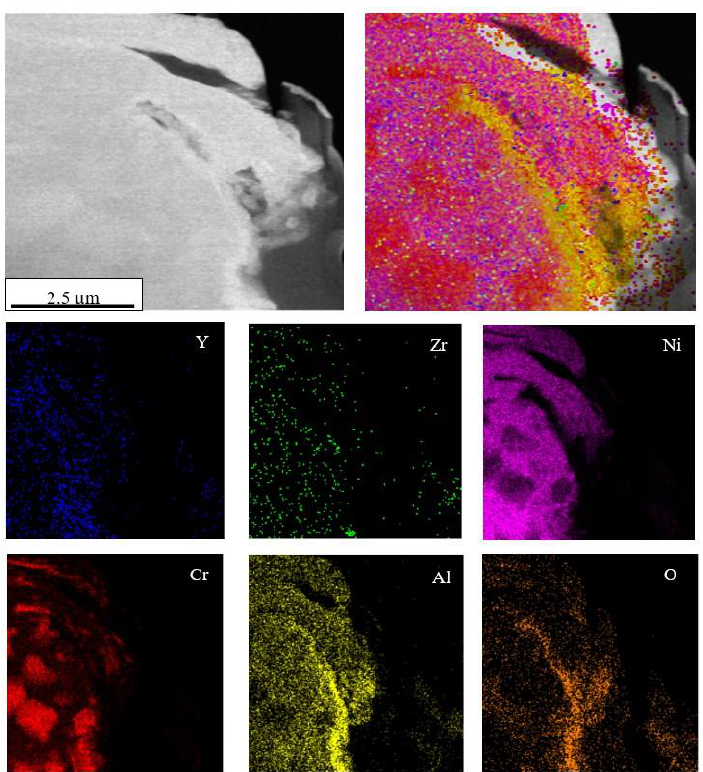
Figure 7. Cross-sectional microstructure and the corresponding EDS mapping of sample, H.